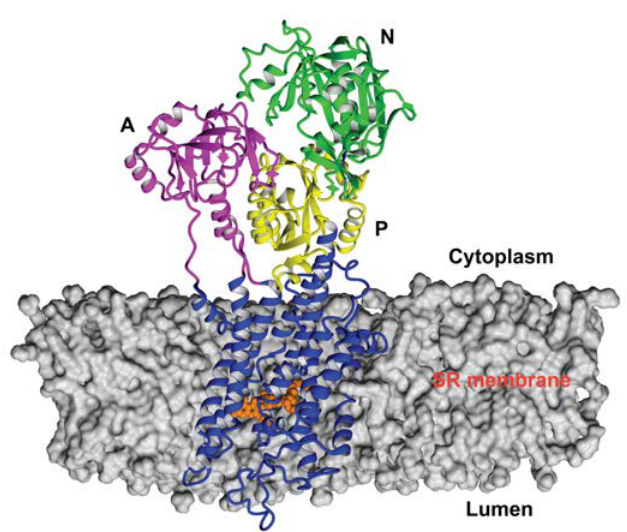
Figure 2. Position of RA in the 3w5c model of sarco / endoplasmic reticulum Ca 2 + -ATPase 1a (SERCA1a) obtained by docking and optimization method [33], which was the starting geometry for the MD simulation. RA molecule is shown in the ball style (orange). The A, N, and P domains in the cytoplasm are shown in pink, green, and yellow, respectively. M1 to M10 in the transmembrane region are shown in blue. Figure was rendered using YASARA [42].